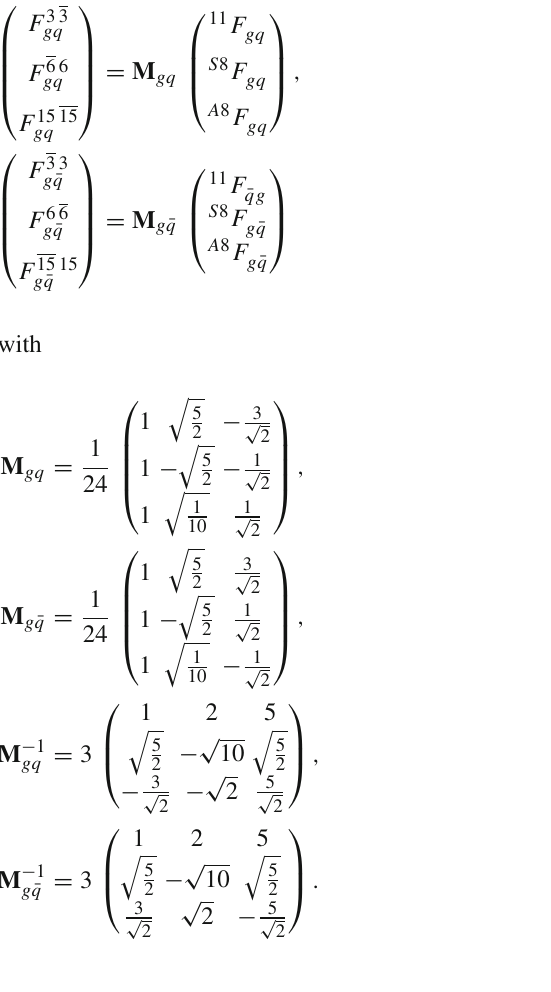
All transformation matrices fulfil the symmetry